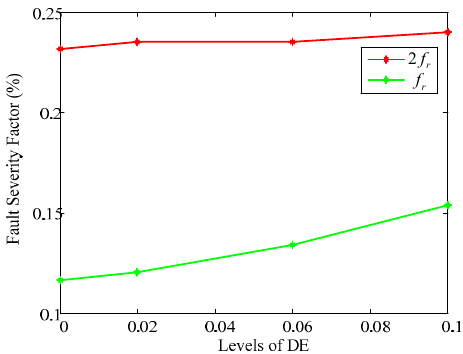
Figure 9. Variation of FSF for an induction motor at no load. Table 1. FSFs and the amplitudes of the induction motor under four levels of DE.